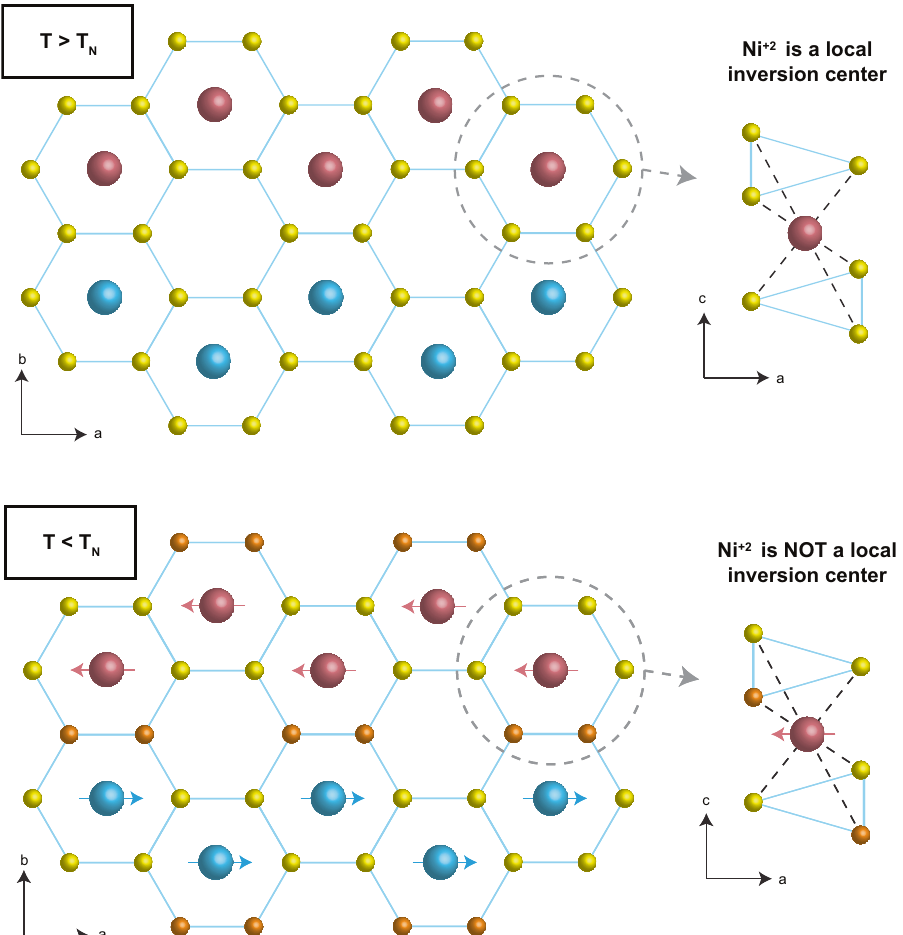
Fig. 5 Magnetism breaks local inversion symmetry enabling d – d transition. With the onset of Néel order, the local environment around nickel sites breaks the local inversion symmetry and makes the electric-dipole forbidden d – d transition visible in the absorption spectrum. For T > T N , all sulfur atoms (yellow) are equivalent, and hence nickel site is a local inversion center. For T < T N , nickel atoms are no longer local inversion centers, as the magnetic order creates two sets of distinguishable sulfur atoms: the ones between the opposite spins (orange) and the ones between the parallel spins (yellow). These dissimilar sulfur atoms break local inversion at nickel sites, as shown on the right.